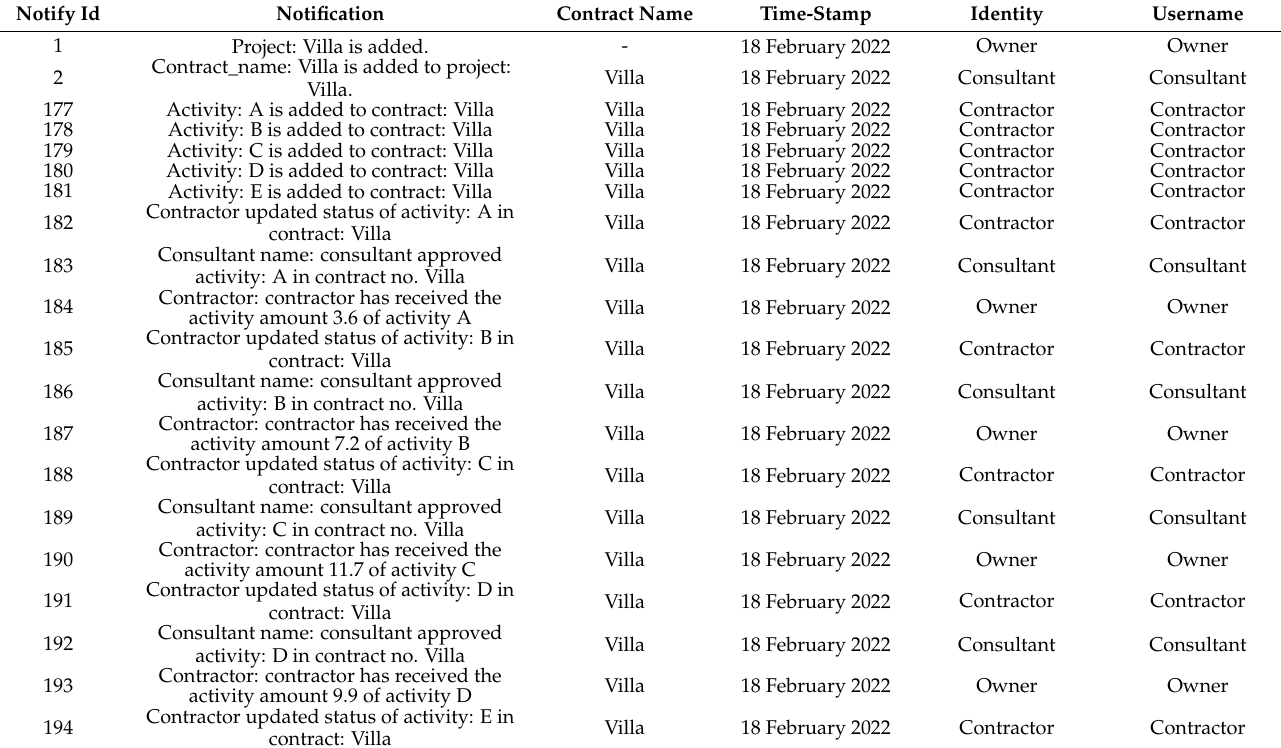
Figure 9. Prototype interface of a sample of submission, approval, and payment in the first milestone. Table 4. The output for the three scenarios procedures from the